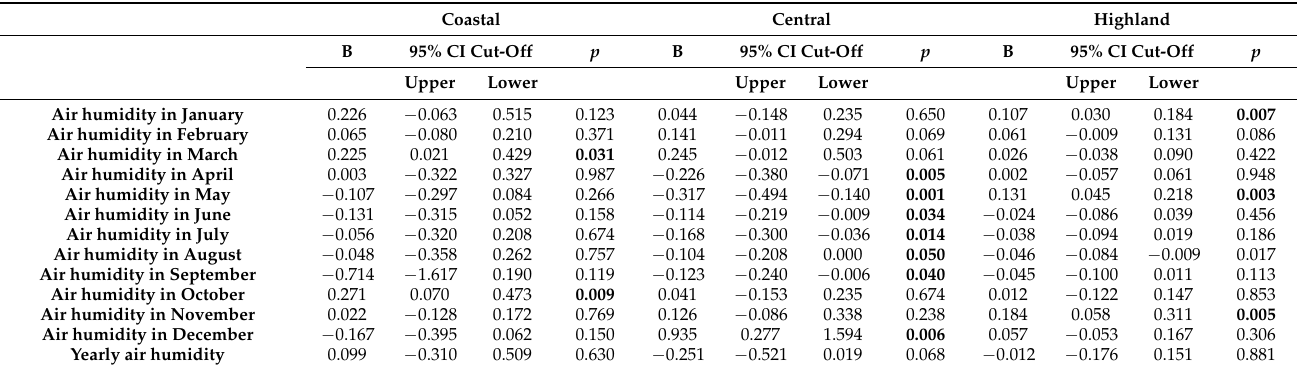
Table 2. Association between the number of cases of leishmaniosis and air humidity (%) in coastal, central, and highland Montenegro. Coastal Central Highland B 95% CI